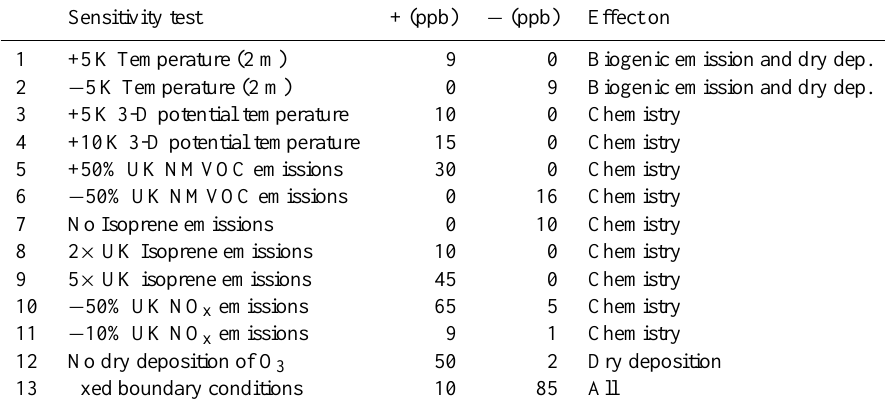
Table 1. Summary of the maximum changes in model-simulated ozone at the Writtle site during the first 15 days August 2003 induced by each of the various sensitivity model experiments described in this work.